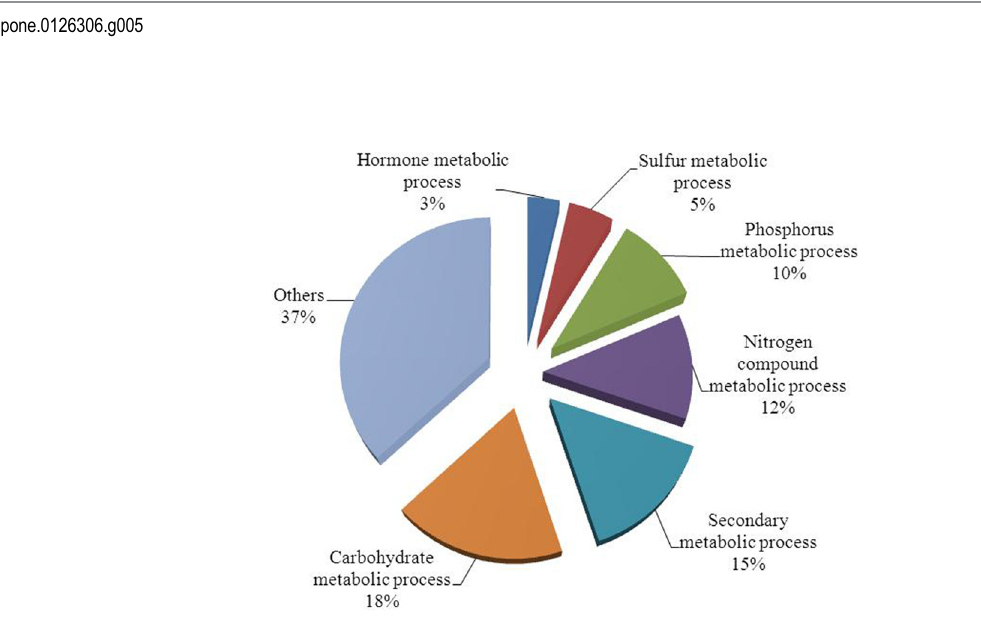
Fig 6. Functional classification of metabolic gene responses to low-K stress.